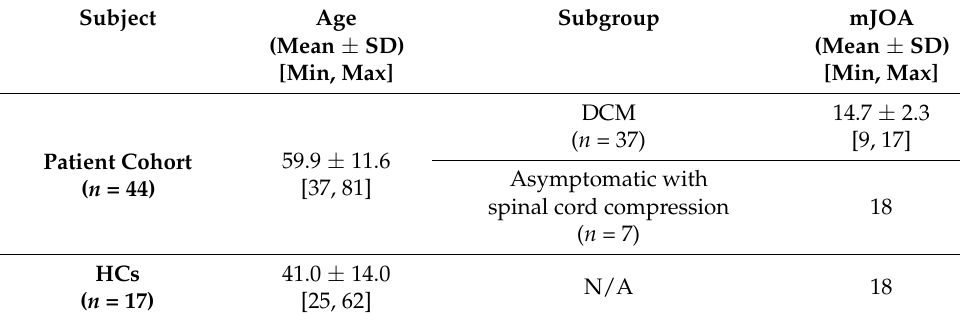
Table 1. Cohort Demographics for Diffusion Tensor Imaging